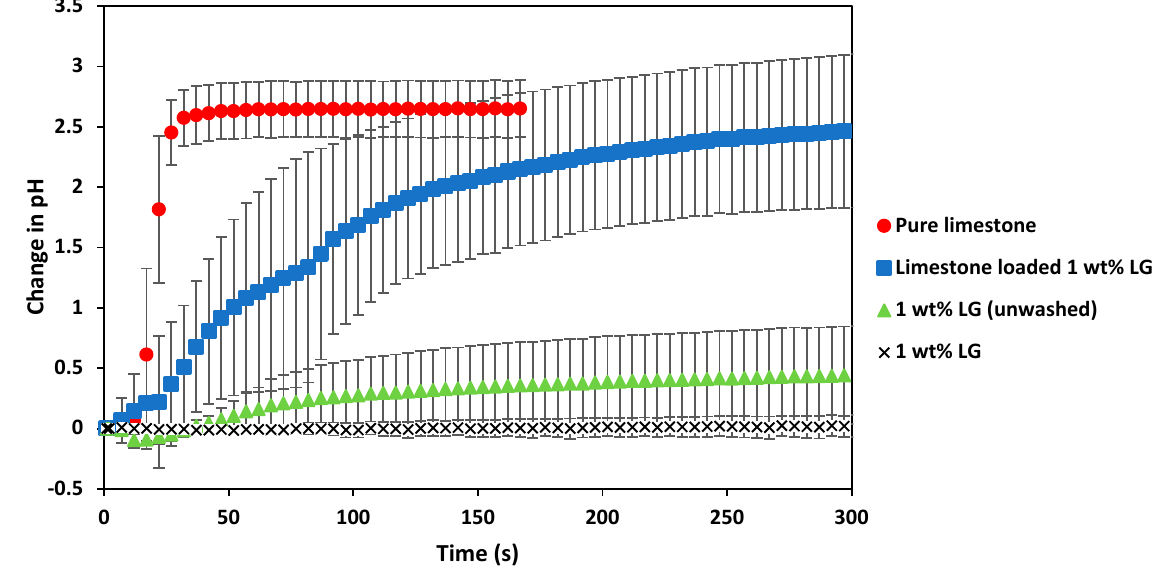
Figure 5. Change in pH over time with the addition of pure limestone ( ● ), 1 wt% laboratory-grade alginate hydrogels (no CaCO 3 addition) ( ▲ ), 1 wt% laboratory-grade alginate hydrogels (no CaCO 3 addition and washed) ( × ) and hydrogels with added CaCO 3 ( ■ ). Error bars show the standard deviation between triplicate experimental runs. ANOVA analysis with a significance of 0.05 was applied to the equilibrium results.